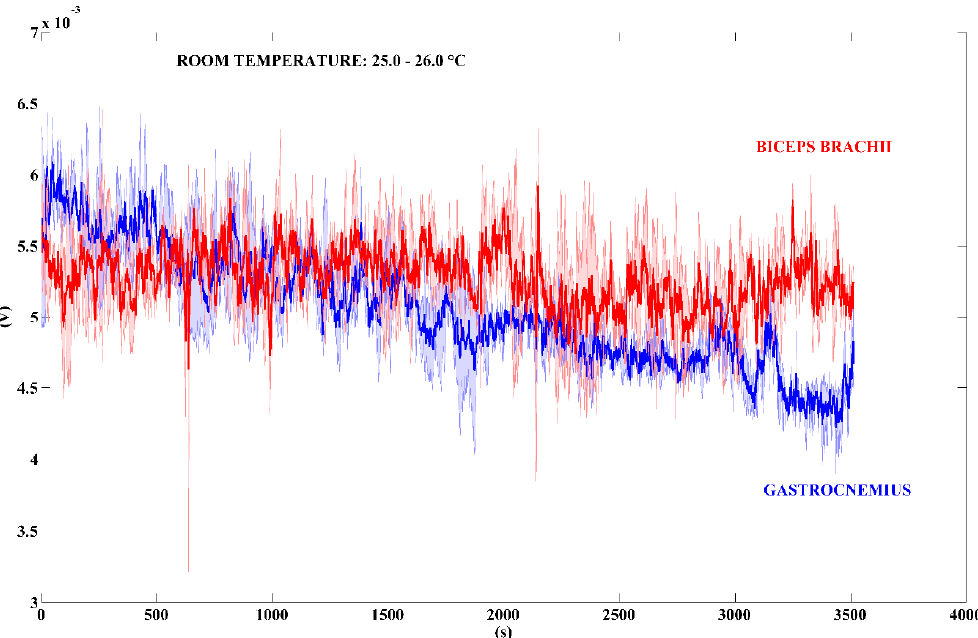
Figure 10. Voltage output signals generated by the TEG. The bold red line represents the mean value of the TEG placed on the biceps brachii; the bold blue line refers to the gastrocnemius. The blue and red areas around the bold lines represent the standard deviations (n = 5). Time-interval: 3500 s. Table 3. Mean power values (n = 5). Working at desk activity.